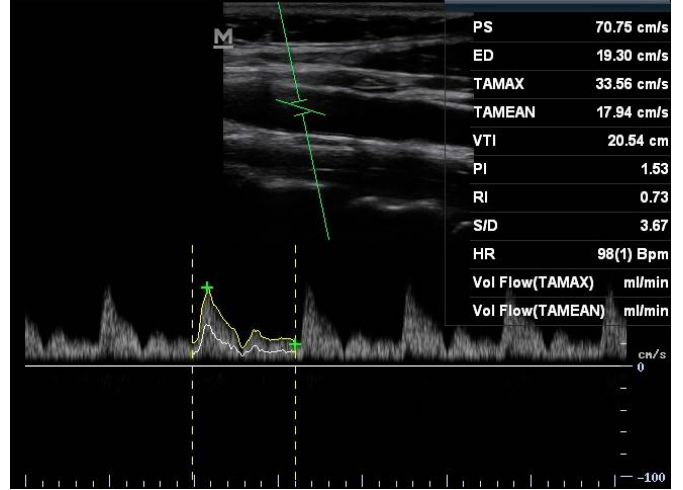
Figure 2. Ultrasound image of common carotid Doppler waveform and velocity time integral measurement acquired with an insonation angle of 58 degrees. The upper spectral waveform tracing (hollow arrow) represents peak flow velocity and the lower spectral waveform (solid arrow) represents mean flow velocity. Plus signs on the spectral waveform represent peak systolic velocity and end diastolic